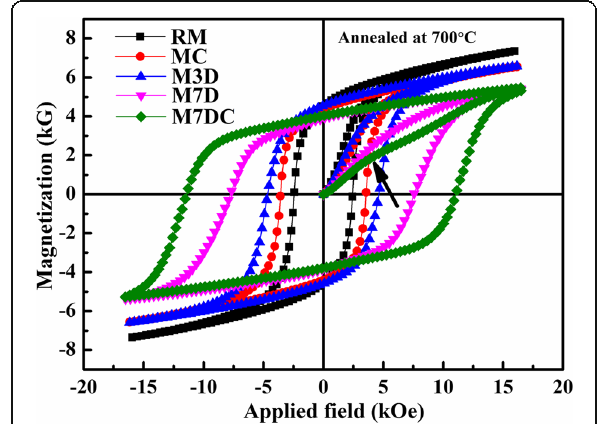
Fig. 3 Room temperature magnetic performance of the samples annealed at 700 °C. The black arrow indicates a region of strong domain